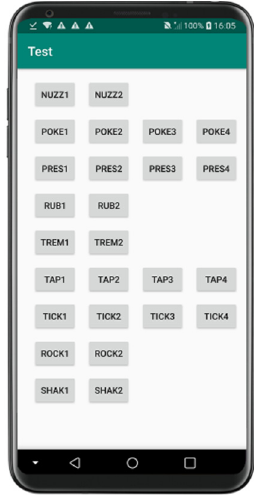
Figure 2. Test interface. This figure was extracted from